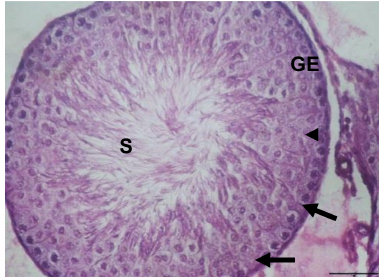
Figure 2. Section of testis in control group rats showing normal structure of seminiferous tubules with normal germinal epithelium (GE), Sertoli cells (arrow), and sperm (S) ( × 400).